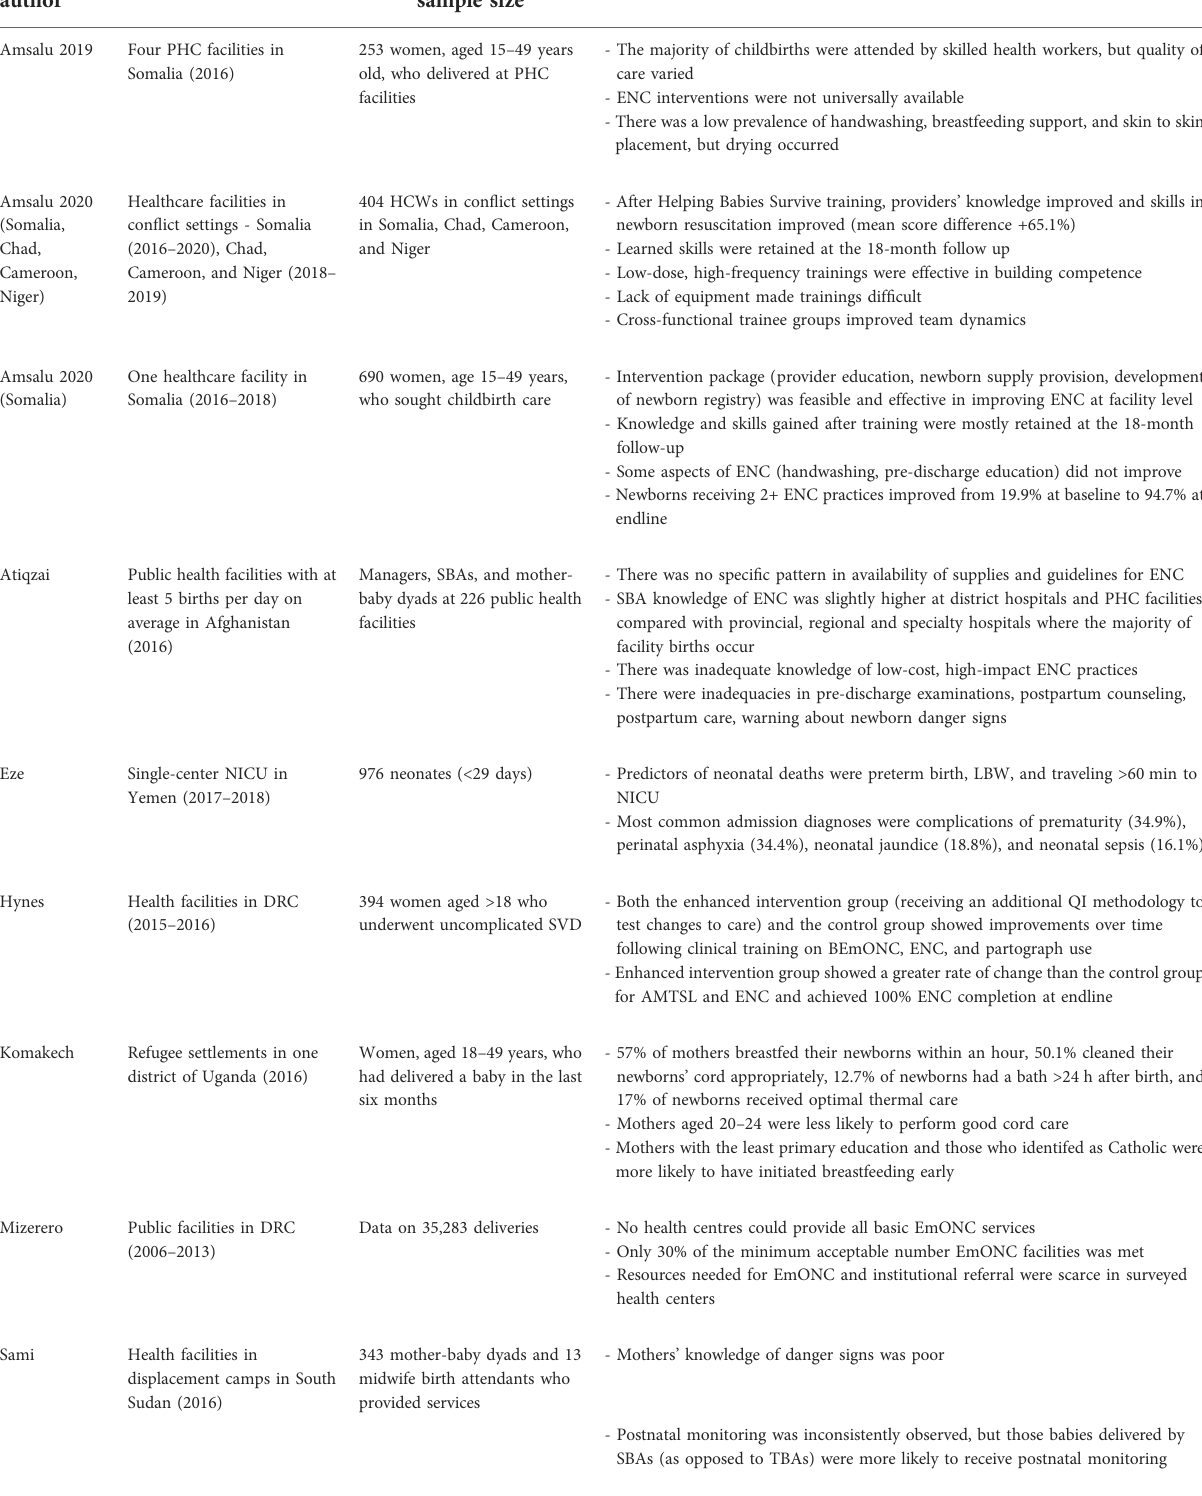
TABLE 2 Overview of included studies with study characteristics and summaries of key fi